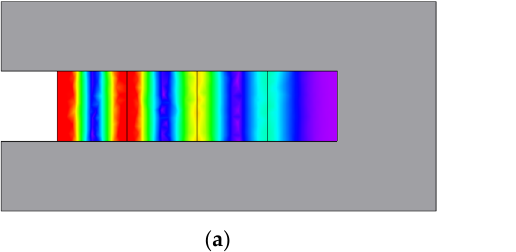
Figure 2. Slot-level current density contour plot (excitation condition: 80 Apk/conductor at 2 kHz): ( a ) 4 conductors; ( b ) 8 conductors.